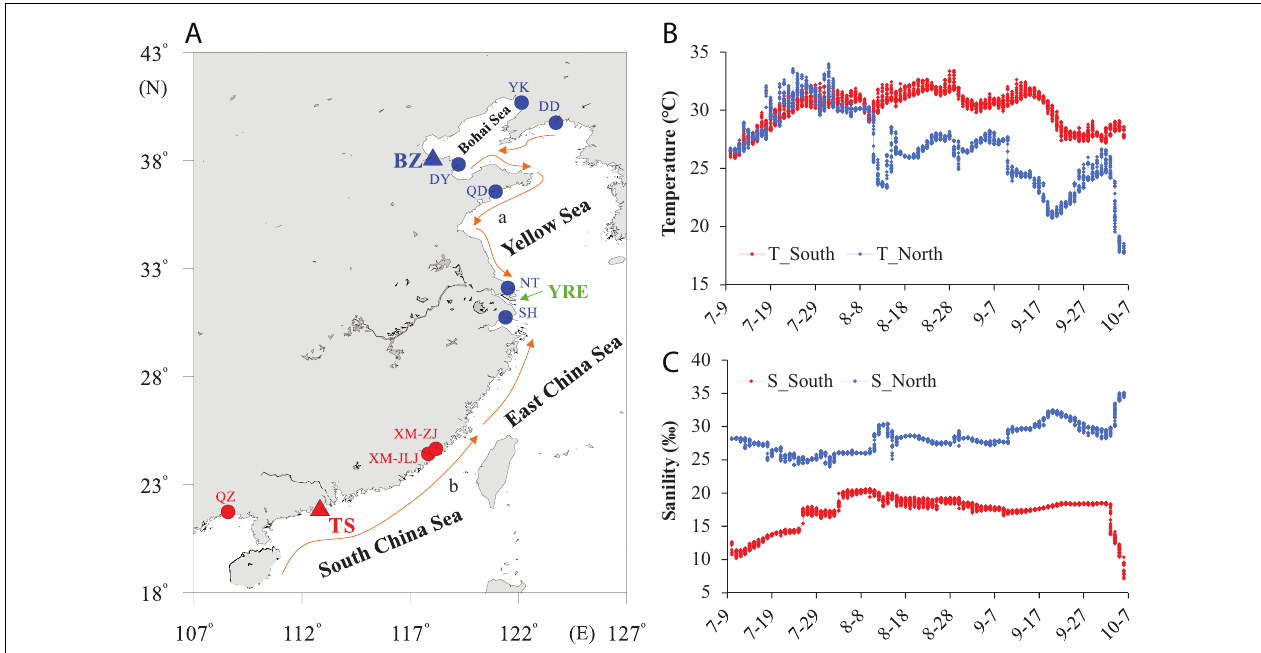
FIGURE 1 | Sampling locations and environmental parameters. (A) Sampling map showing the locations of 11 C. ariakensis populations dwelling in estuaries along the coasts of China. Two populations derived from the southern (Taishan: TS) and northern (Binzhou: BZ) habitats were selected for the phenotype assessments (triangle). (A) China Coastal Current; (B) South China Sea Warm Current. (B) Seawater temperature and (C) salinity of the two selected locations recorded by a conductivity logger with a 1 h interval. T: temperature, S: salinity, YK: Yingkou, DD: Dandong, DY: Dongying, QD: Qingdao, NT: Nantong, SH: Shanghai, XM-ZJ: Xiamen-Zhangjiang, XM-JLJ: Xiamen-Jiulongjiang, QZ: Qinzhou, YRE: Yangtze river estuary. The arrowed curves indicate coastal currents in the summer in